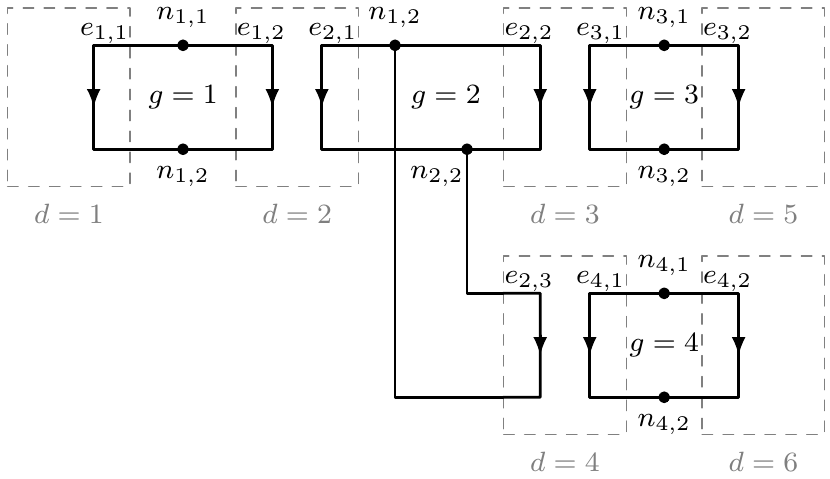
Figure 4. Directed graph representation of the electrical network of Figure